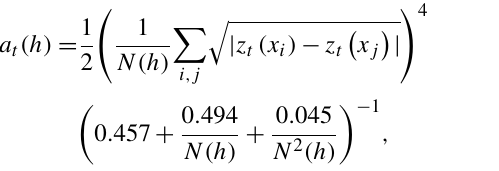
in the figure at the very bottom. Both recorded values close to or even below 0.1 cm 3 cm − 3 for the whole period of 4